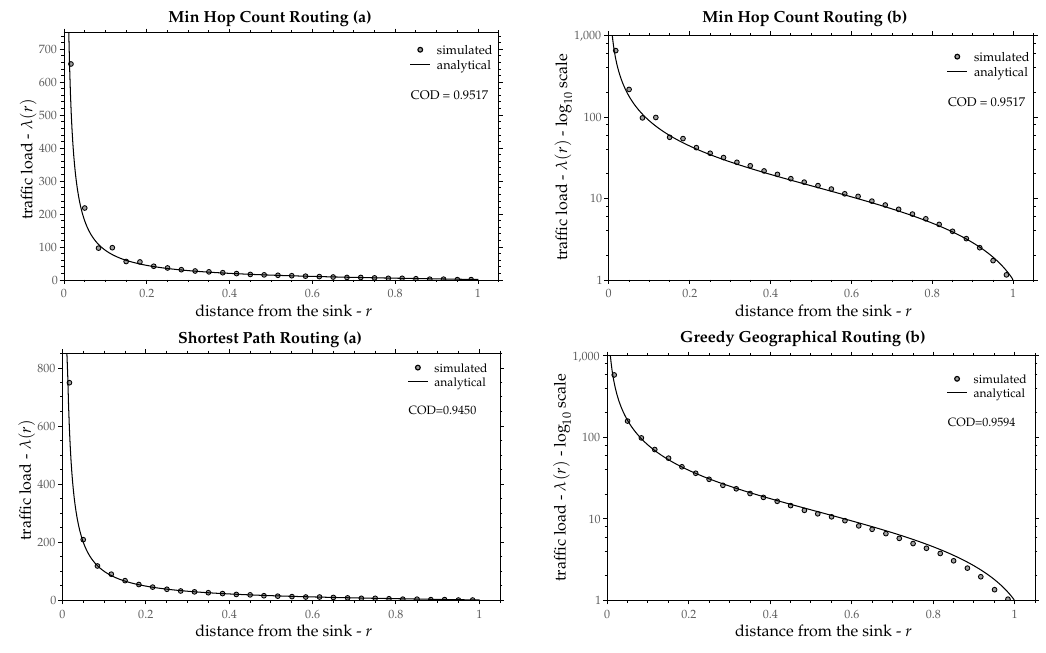
Figure 11. Comparison between Equation (25) and the simulated traffic load as a function of the distance from the sink for two routing schemes, Min Hop Count and Shortest Path. ( a ) normal (linear) plot, ( b ) semi-log plot (log-linear).